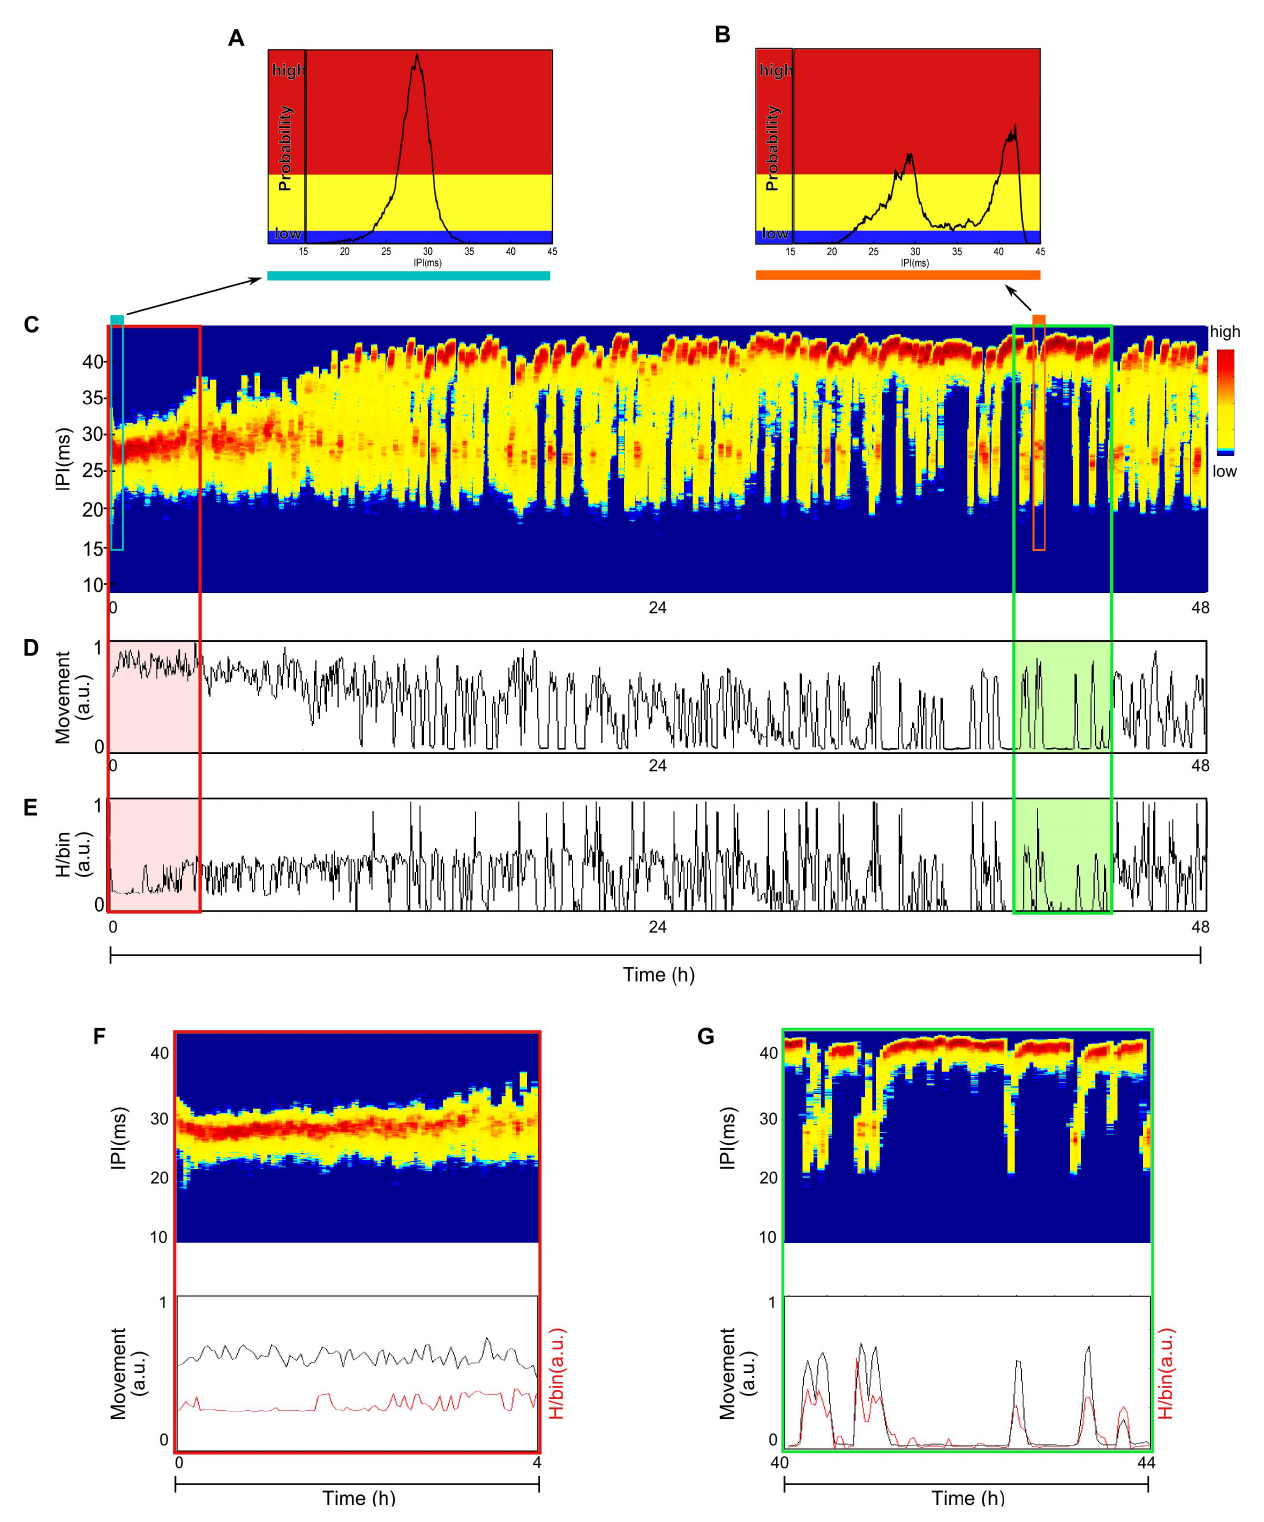
Figure 4. Non stimulated fish (48 h experiment). A – IPI histogram of the first 240 s after the fish is introduced to the tank. The colors are a code for highly probable IPIs (red), intermediate probable IPIs (yellow) and low probable IPIs (blue). In the beginning of the experiment the fish was more likely to fire 27 ms IPIs. B – IPI histogram for 240 s in the stationary period. The color code is the same as in A. During the stationary period the shape of the IPI distribution was bimodal with peaks in 28 ms and 40.5 ms. C – Sliding window histogram (SWH) of IPIs versus time. The histograms were calculated in 40 s windows and colors were assigned depending on the probability as explained in A. The sliding window histogram was built taking the colorcoded histogram for the first 40 s window and placing it in a vertical line in SWH, the second 40 s window colorcoded histogram was placed in the next vertical line in SWH and son on, allowing one to observe how IPIs evolve over time. There was a transient behavior, at the